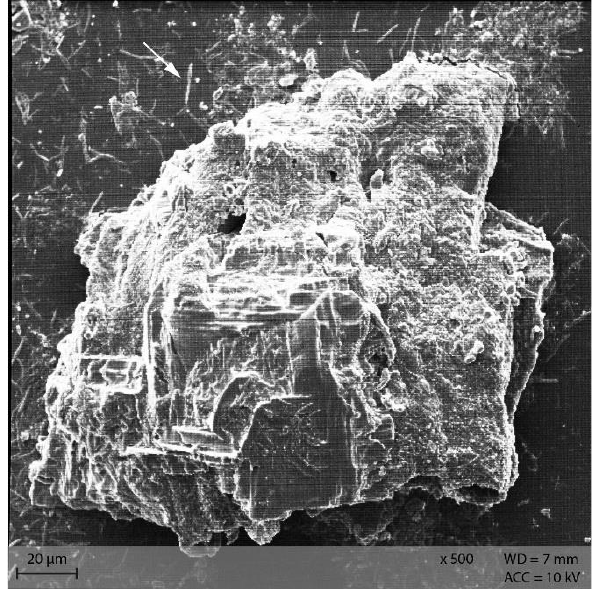
Figure 13. Caecum content sample from diet group EXT showing a large, crystalline shape (Scanning electron microscopy, ↓ indicating bacteria in the background).